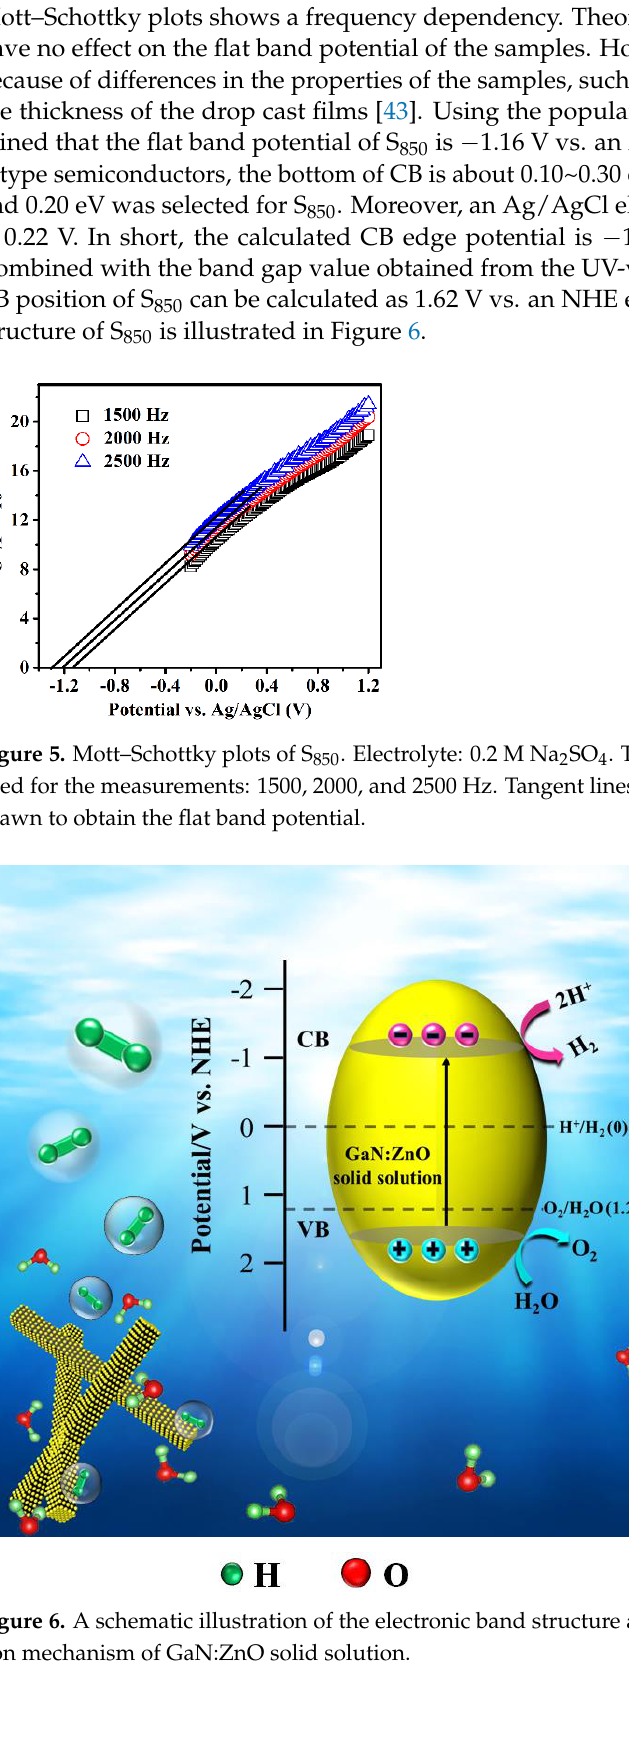
( f ) Figure 4. ( a ) Photocatalytic H 2 evolution and ( b ) H 2 evolution rates of Rh 2-y Cr y O 3 -loaded GaN:ZnO solid solution, ( c ) cycle stability of Rh 2-y Cr y O 3 -loaded S 850 , ( d ) photoluminescence spectra, ( e ) transient photocurrent, and ( f ) EIS Nyquist plots of S 750 , S 850 , and S 950 samples.